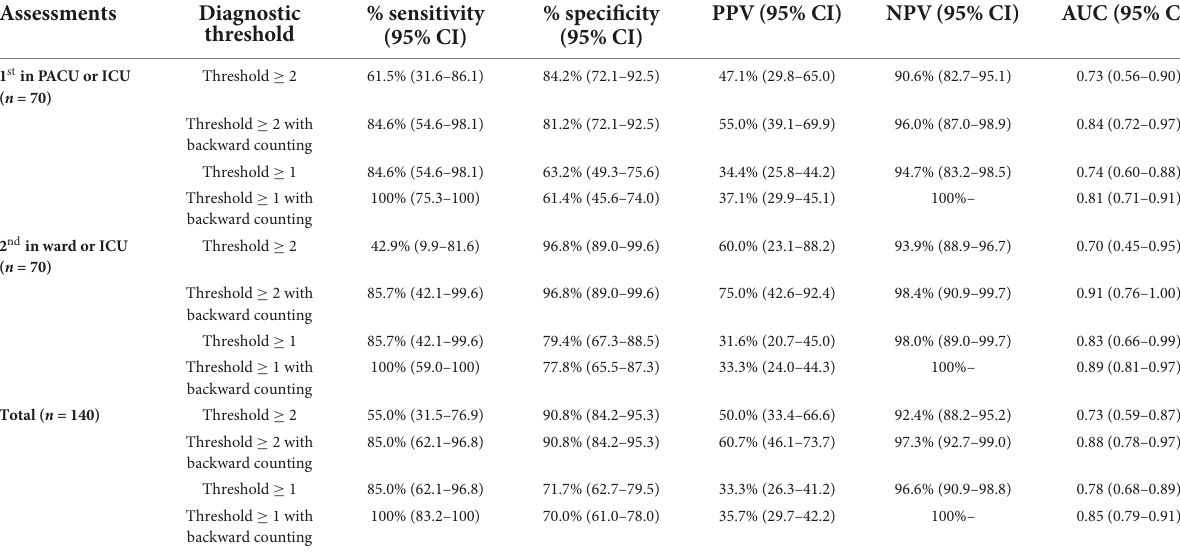
TABLE 3 Delirium screening performance of the Thai-version of the Nu-DESC compared with the DSM-5 standard